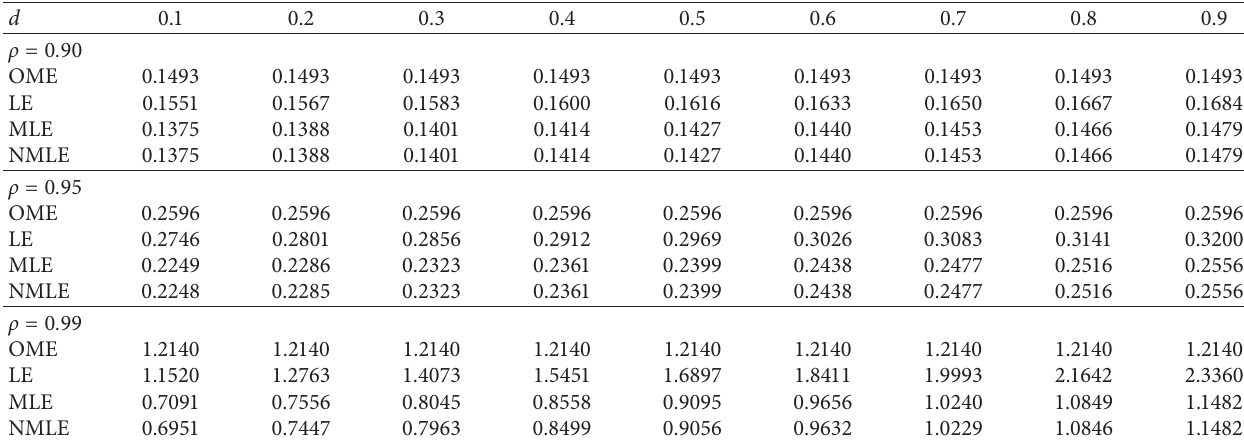
Table 2: MSE values of the estimator for different values of d and ρ when σ � 1 and n �